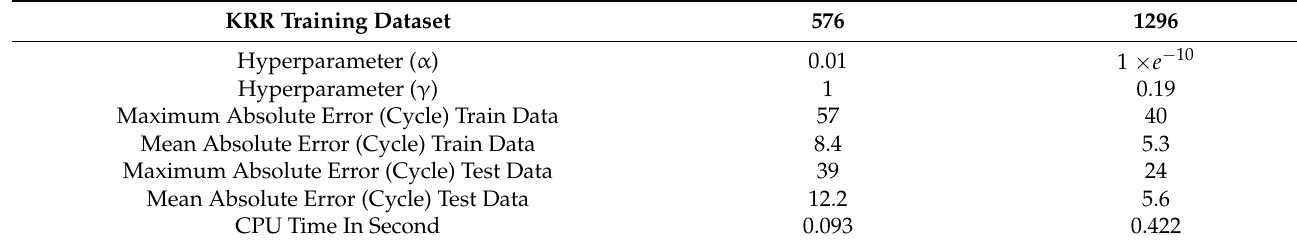
Table 18. KRR result comparison.